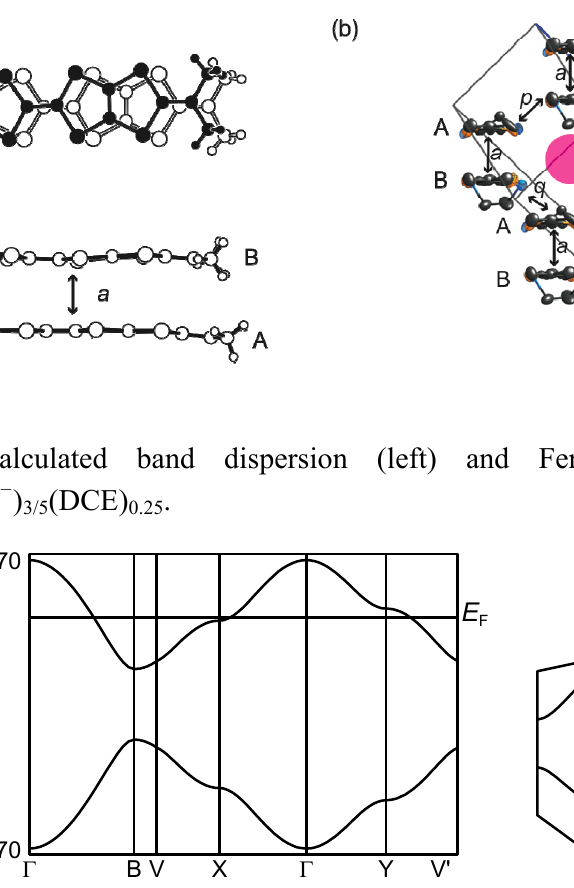
Figure 17. Calculated band dispersion of (MeDTES) + ( I